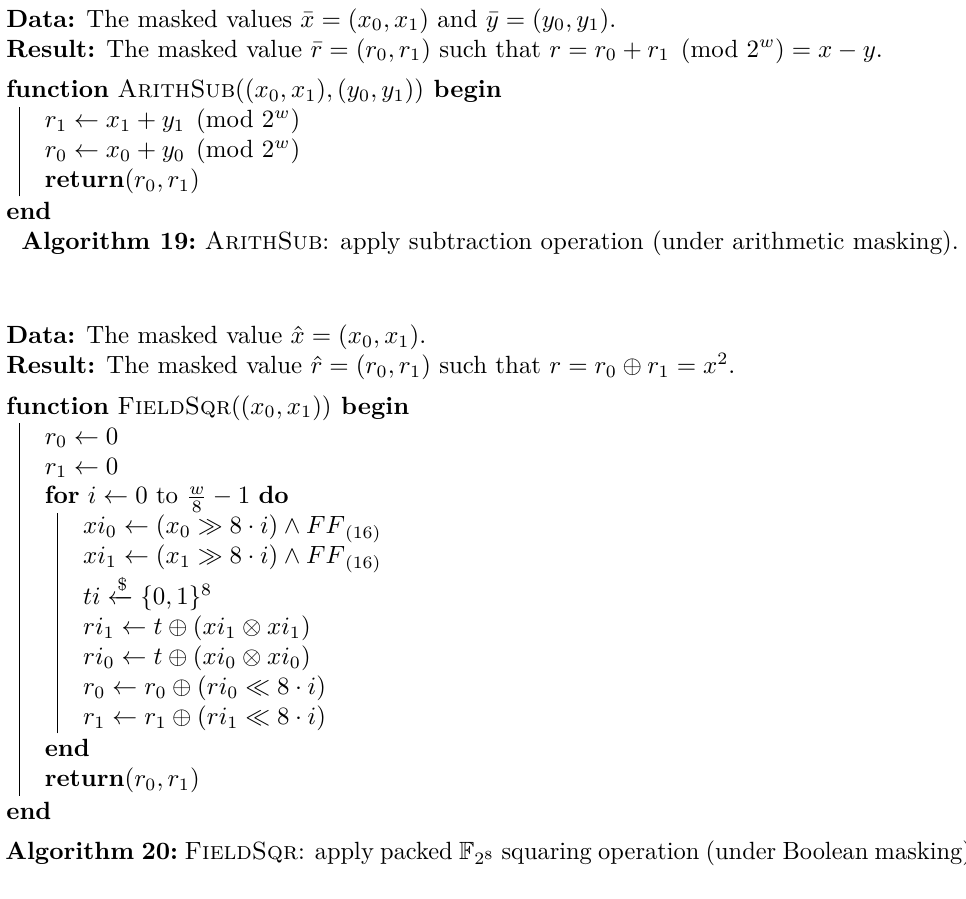
Algorithm 18: ArithAdd : apply addition operation (under arithmetic masking).